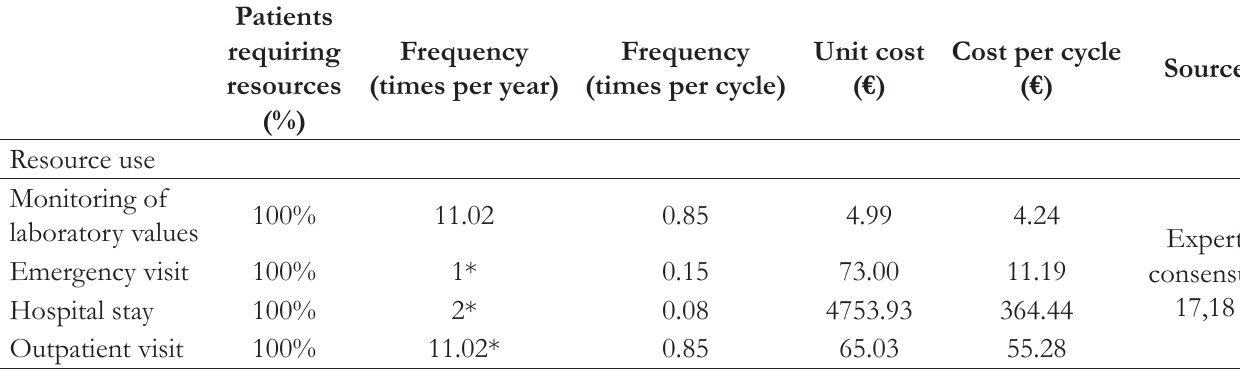
Table 2. Unit Cost, Frequency and Percentage of Patients Requiring Use of Resources